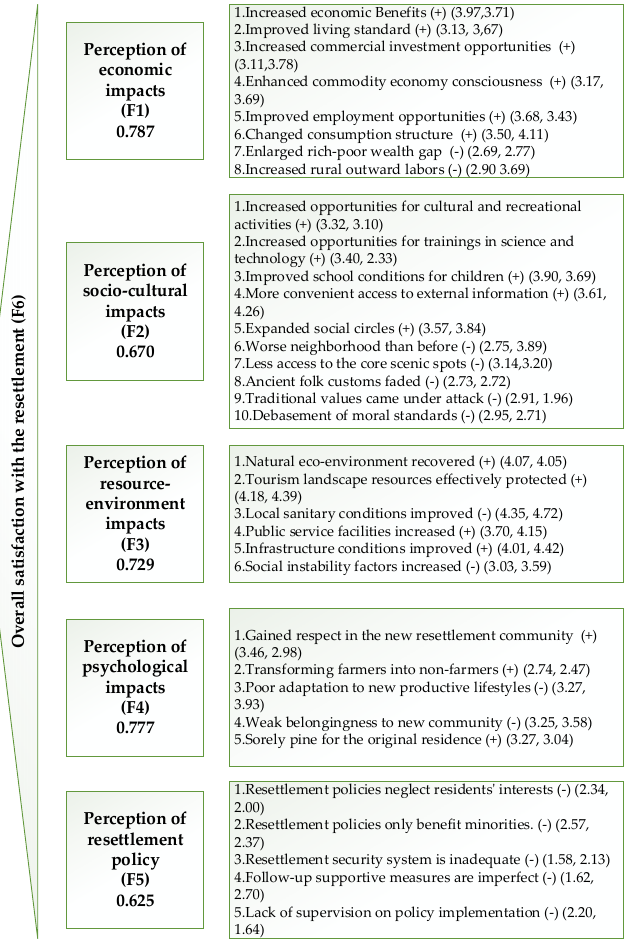
Figure 2. Evaluation framework and index system of resident’s perception of the impact of ecological resettlement. Note: the bold figures represent the Cronbach’s alpha coefficient of each index layer; (+) indicates a positive index, (−) indicates a negative index; (2.20, 1.64) the left side represents the 2010 index value, and the right side represents the 2016 index value.